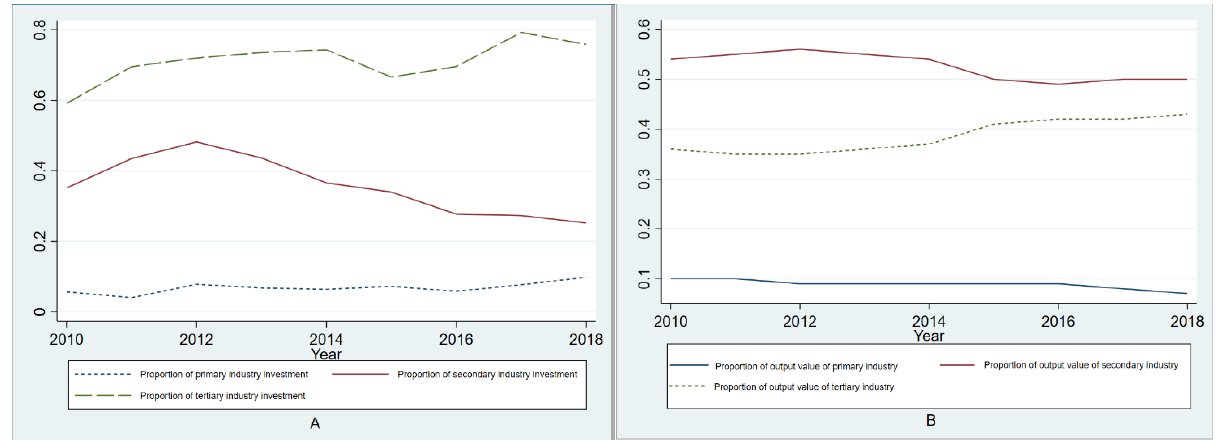
Figure 3. Proportion of investment, ( A ) denotes the proportion of investment in the tertiary industry in Shaanxi, and ( B ) denotes the proportion of investment in secondary industry in Shaanxi.